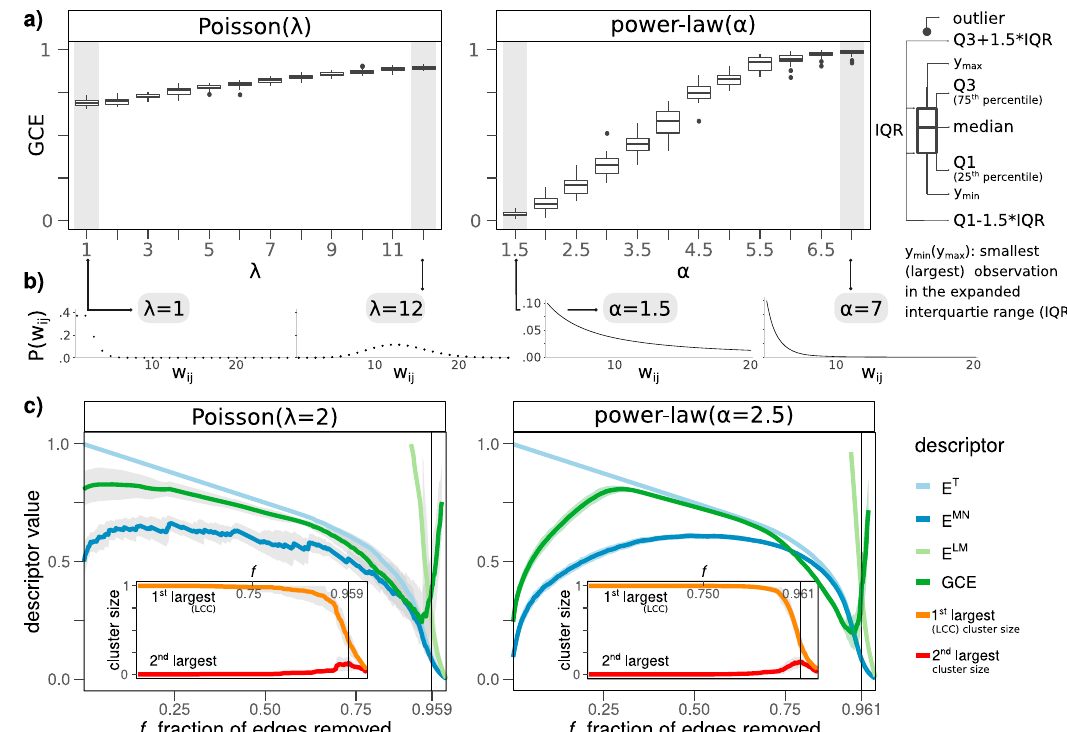
Fig. 2 Communication ef fi ciency of full networks with homogeneous and heterogeneous fl ows. a Global communication ef fi ciency (GCE) as a function of the free parameter λ of the Poisson α and power-law distributions from which fl ows are simulated. The GCE distribution over 30 networks for each parameter value is summarized by the boxplots. In particular the box extends from the fi rst (Q1) to the third (Q3) quartile, the line in the box indicates the median and the whiskers expand the interquartile range (IQR = Q3 − Q1) by ~1.5 in each direction (see the legend). As α and λ increase the heterogeneity of the weights decreases and the GCEs tend to 1, the ef fi ciency of a fully connected, unweighted network. For the highlighted values of λ and α , we report the probability mass/density function of edge weights w ij (all nodes are adjacent) in panel b . c Targeted bond percolation over the same synthetic networks as in a for λ = 2 and α = 2.5. The descriptors are the topological E T , max-normalized E MN , and Latora – Marchiori E LM ef fi ciency, and our GCE. Lines represent the average descriptor value over the 30 networks, while shaded areas the standard deviations. The average GCE bene fi ts from the removal of heavy links which forces the network to rearrange its paths. The insets show the behavior of the size of the largest and second largest connected component for f ∈ [0.5, 1]. Vertical black lines indicate critical thresholds f c (corresponding the maximum of the second largest component size). Values on the y axis have been cut to the range [0, 1] — full plot in Fig.